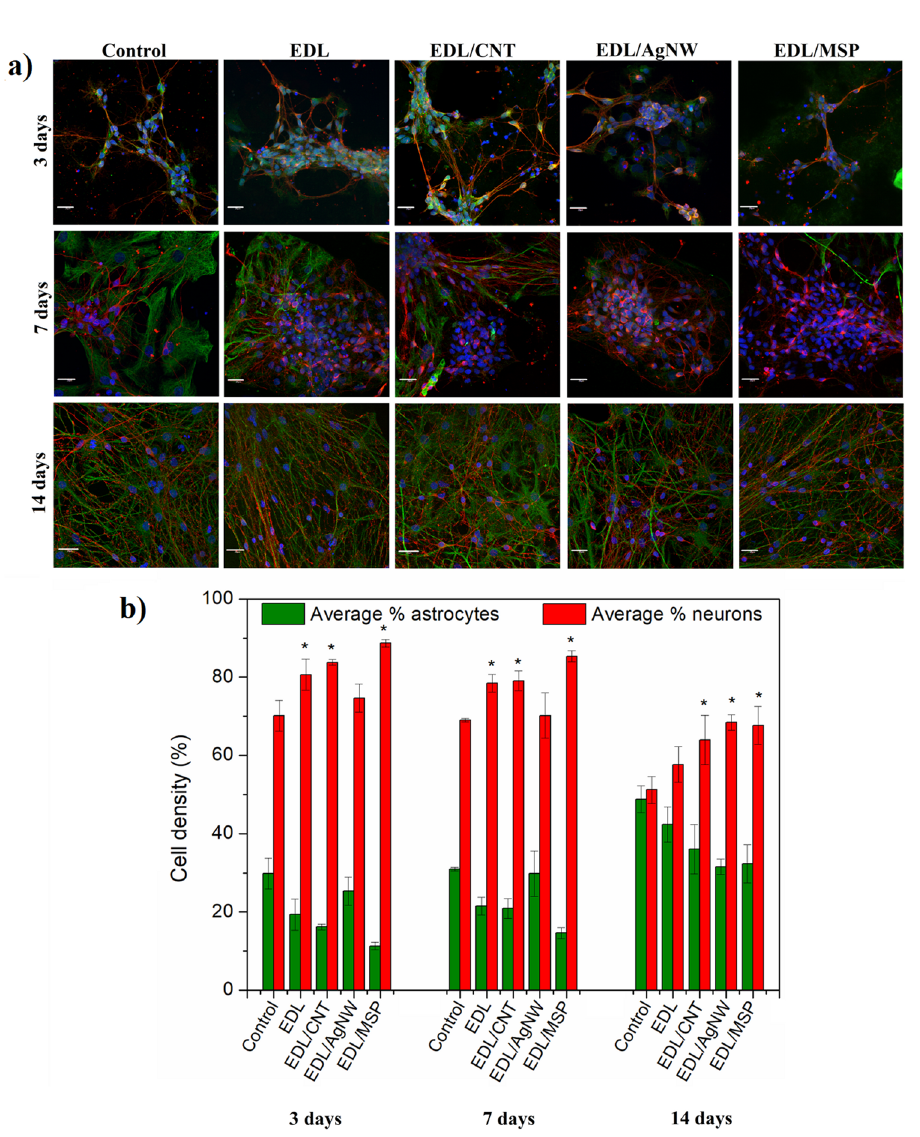
Figure 5. Biocompatibility of EDL-based composites. Fluorescent images of primary ventral mesencephalic mixed cell population cultured for 3, 7 and 14 days on a control substrate (bare Pt-coated glass slide), pristine EDL, EDL/CNT, EDL/AgNW and EDL/MSP; neurons are visualized by anti β-tubulin III (red), astrocyte cells by anti-GFAP (green) and nuclei by DAPI (blue); the scale bar represents 20 μm ( a ). Cell density (%) analysis of astrocyte and neuron presence on each of the experimental and control group ( b ); n = 3, * = p <